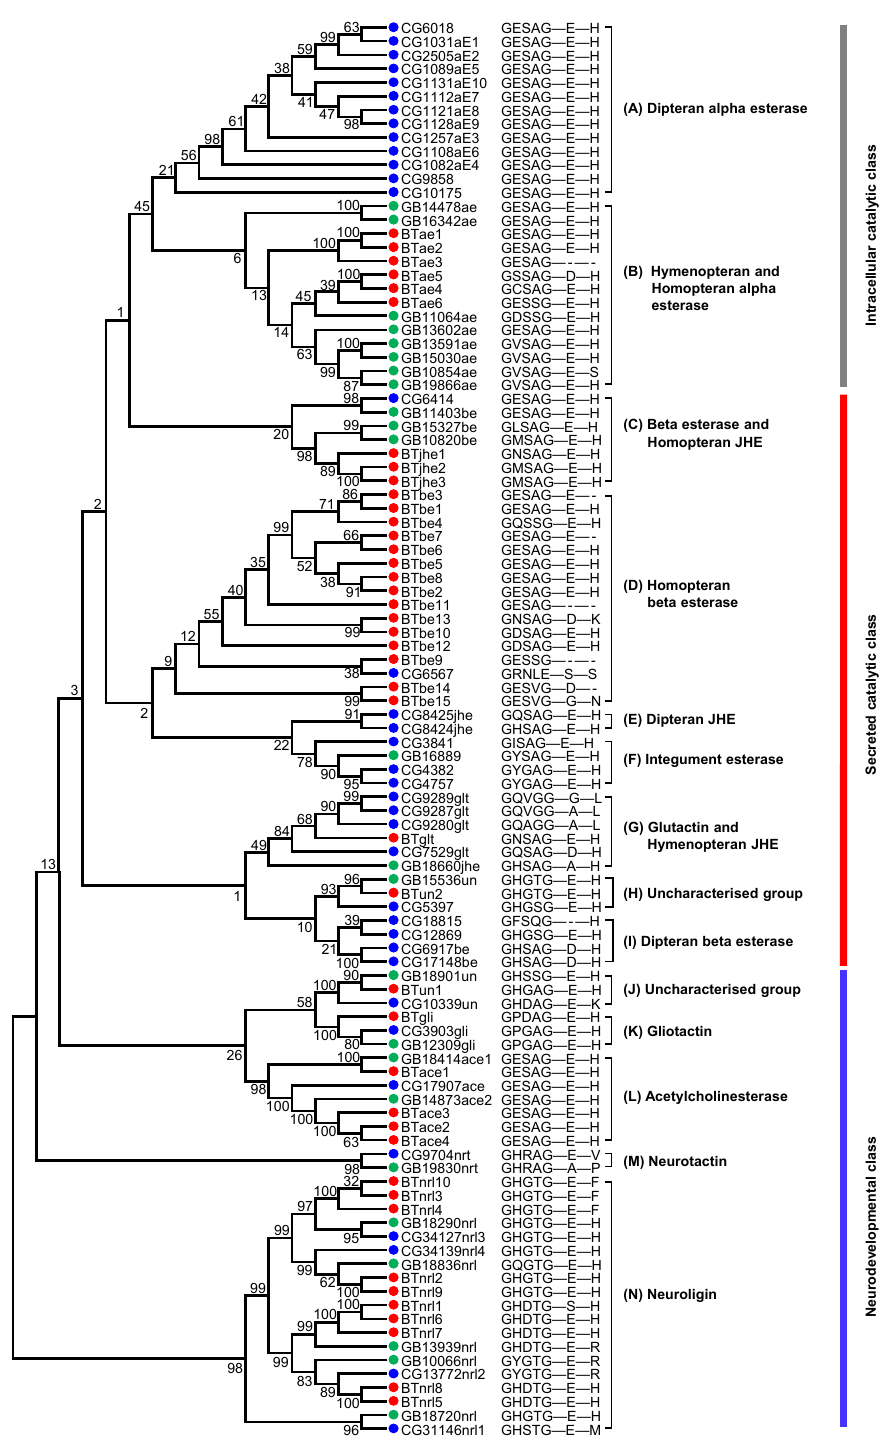
Figure 1. Phylogenetic tree of COEs in B. tabaci MED. A total of 103 COE amino acid sequences were used in the phylogenetic analysis. The phylogenetic tree was constructed using MEGA 6 with the neighbor-joining (NJ) method based on the Jones–Taylor–Thornton (JTT) model with a uniform substitution rate. Bootstrap values shown at branch points are expressed as percentages calculated from 1000 replicates. The catalytic residues and GXSXG consensus sequence around serine active site are shown at the right of the phylogenetic tree. B. tabaci MED (red circles); D. melanogaster (blue circles); A. mellifera (green